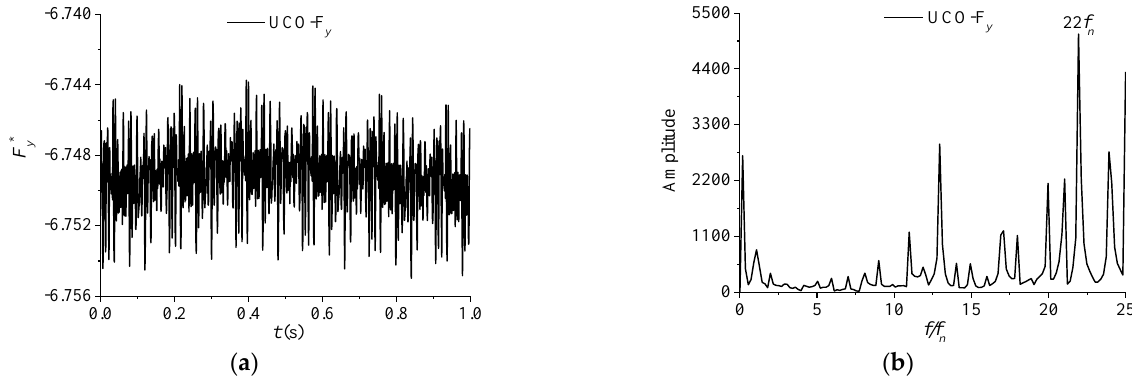
Figure 13. The axial water thrust of the runner upper crown outer surface. ( a ) Time domain diagram of UCO-F y . ( b ) Fre- quency domain diagram of UCO-F y .